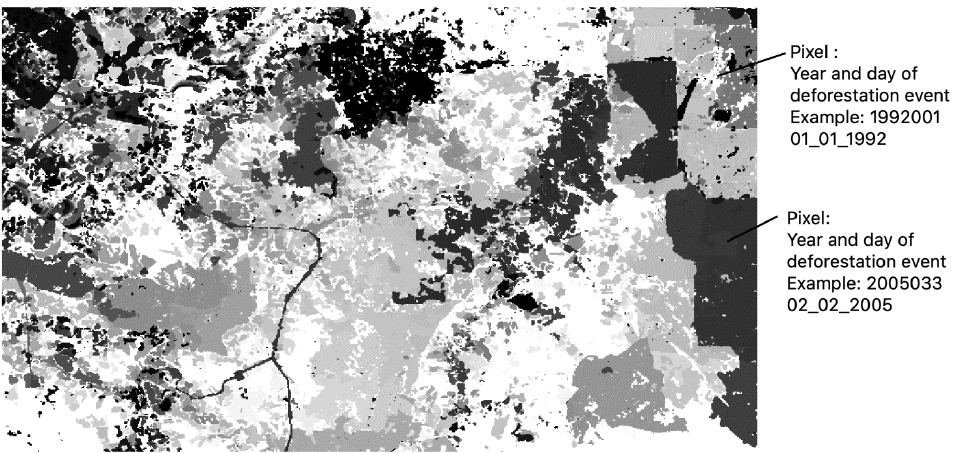
Figure 4. Deforestation of North Sumatra, Indonesia, 1988–2021.